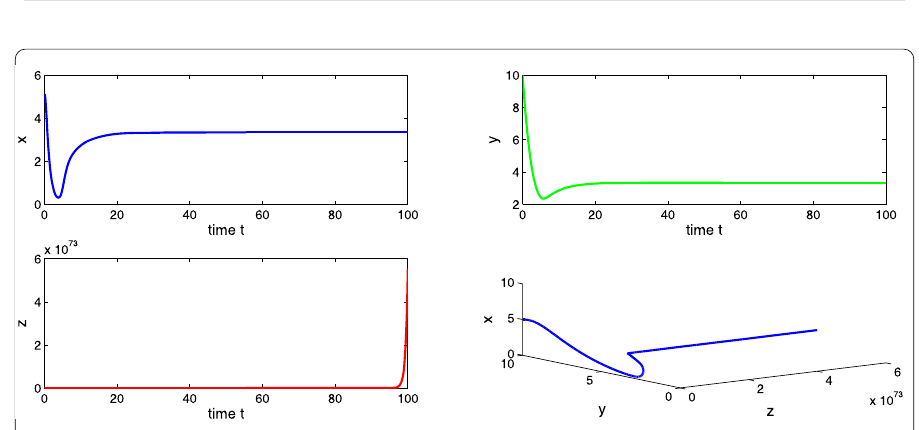
Figure 13 Time evaluation curve and three-dimensional phase portrait of the system for the parameter values a